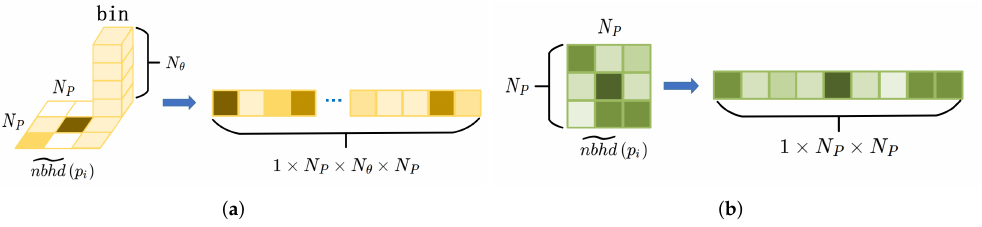
Figure 4. Generation of the histogram. ( a ) Grids and bins are expanded to an array. ( b ) Grids are expanded to an